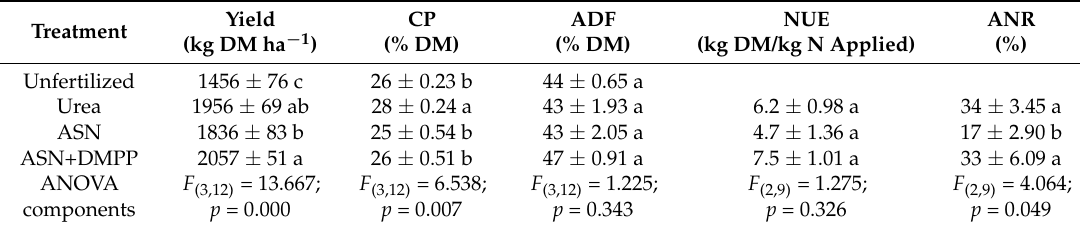
Table 3. Yield (dry matter (DM) production), crude protein (CP) content, acid detergent fiber (ADF) content, nitrogen use efficiency (NUE), and apparent nitrogen recovery (ANR). Values in cells with different letters are significantly different ( p < 0.05; n =